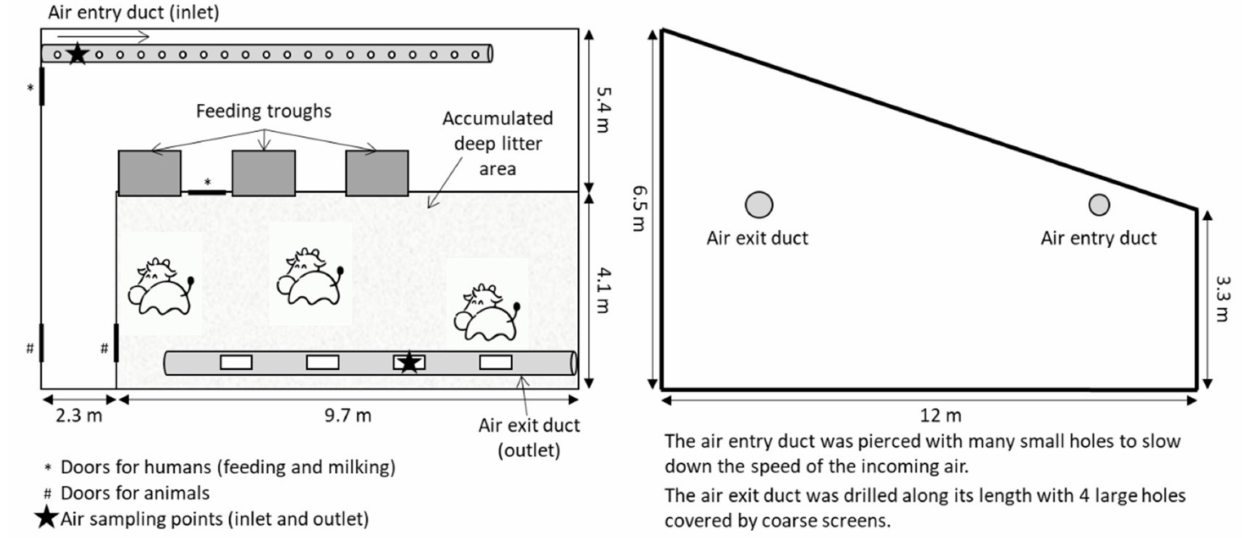
Figure 1. Overhead ( left ) and side ( right ) views of one of the experimental rooms that housed three dairy cows (diagrams are not to